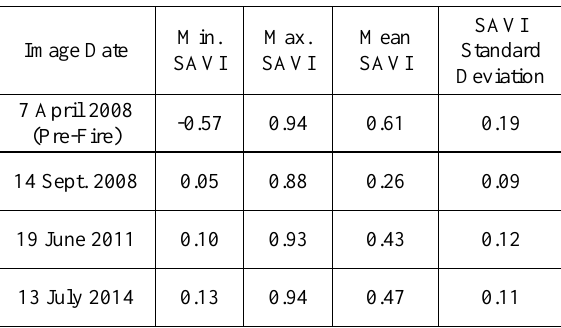
Table 3. Multitemporal SAVI statistics